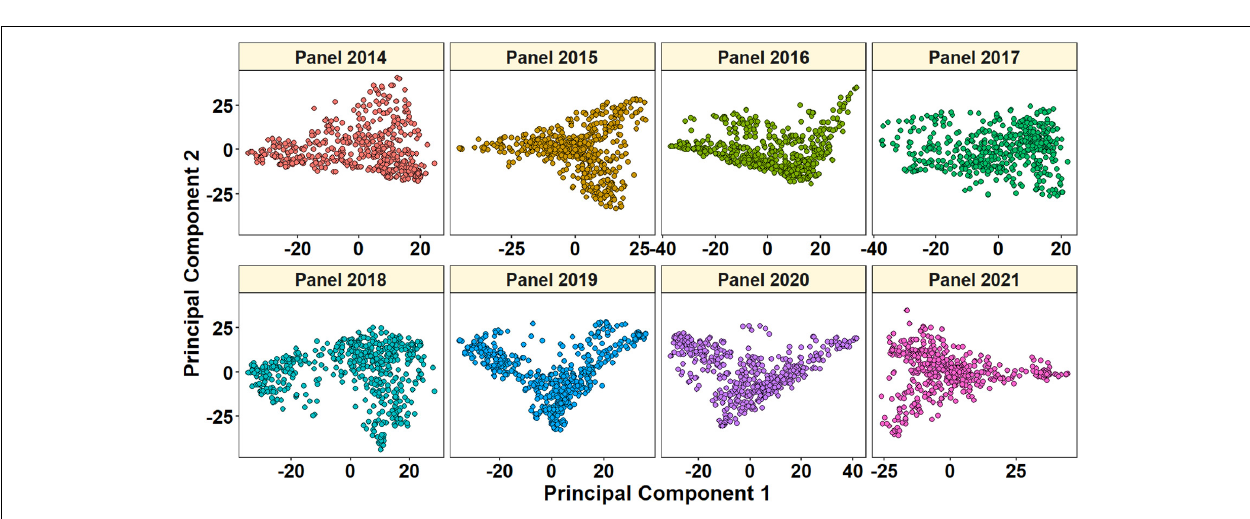
FIGURE 3 | Plot of principal components 1 and 2 indicating the population structure in panels